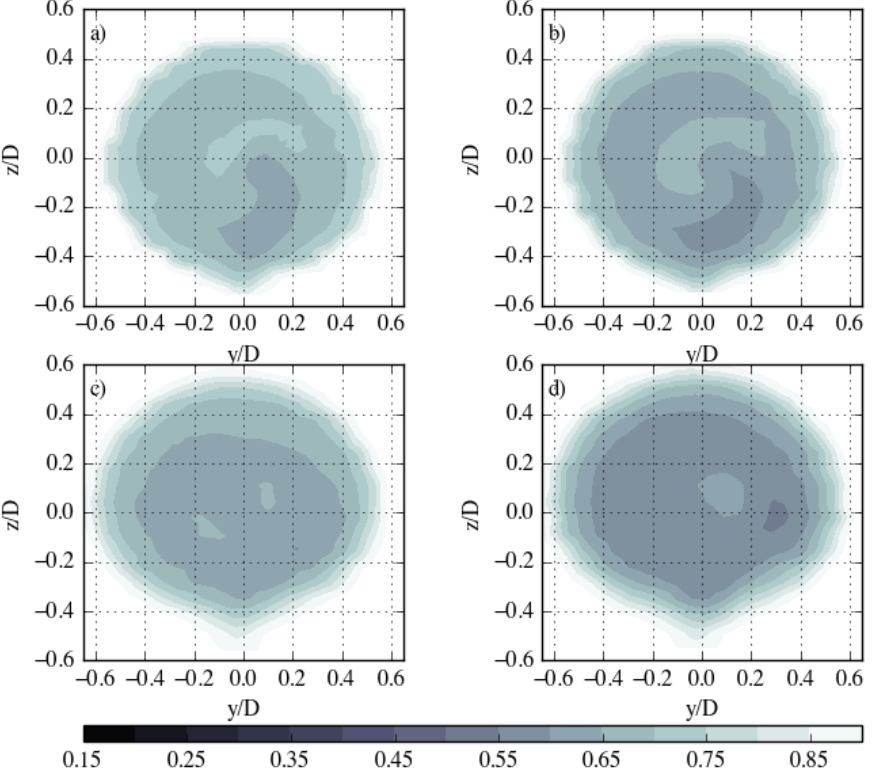
Figure 9. Experimental mean axial velocity at x / D = 1 ( a , b ) and x / D = 3 ( c , d ) for the balanced rotor ( left column ) and + 5 ◦ unbalanced rotor ( right column